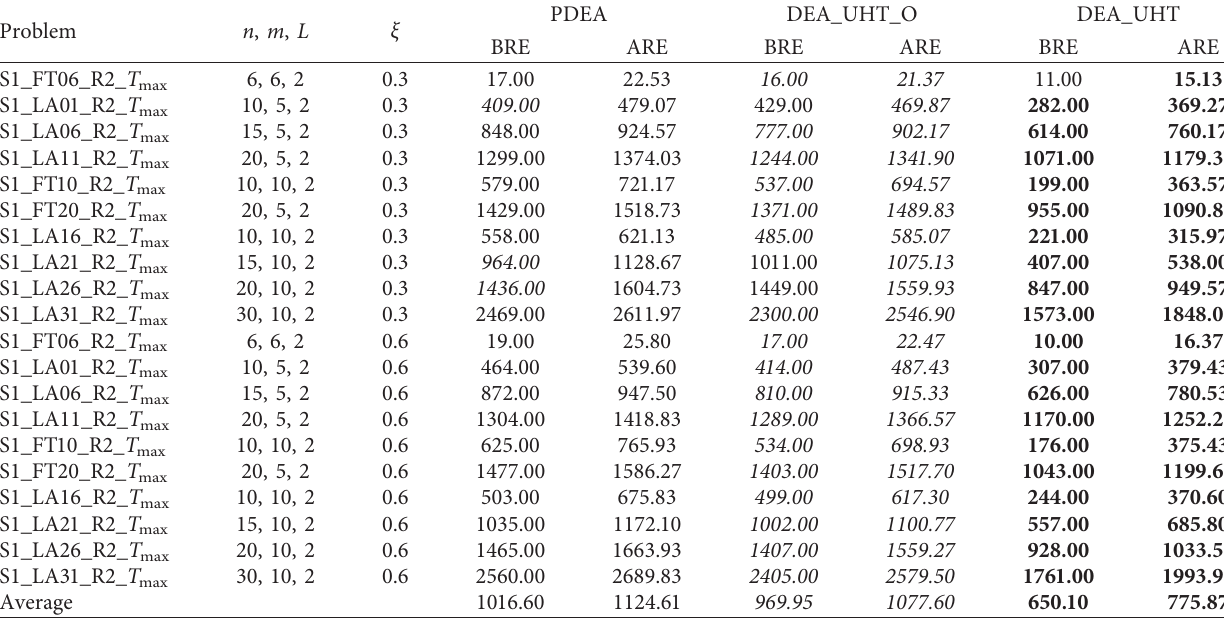
Table 2: Comparisons of PDEA, DEA_UHT_O, and DEA_UHT.